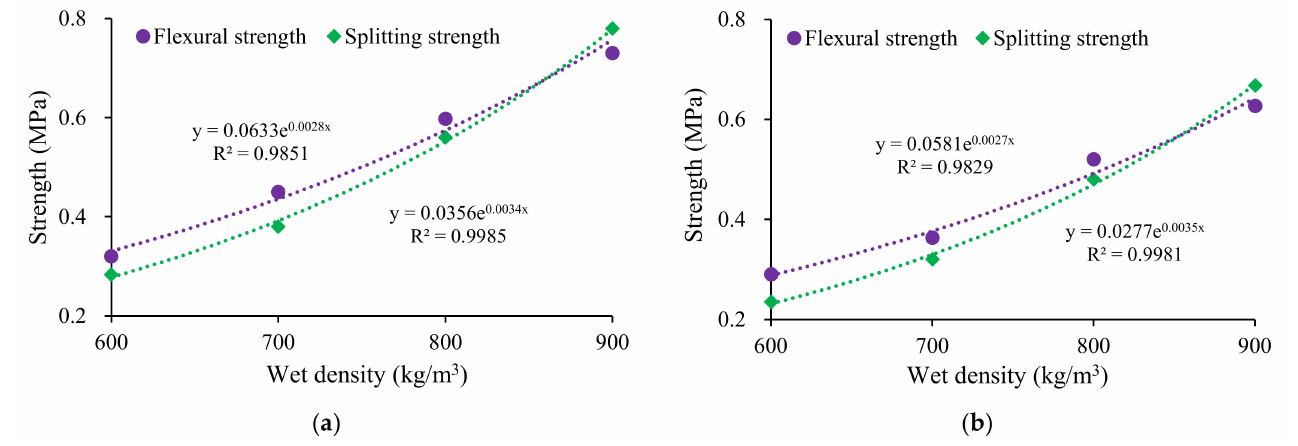
Figure 5. Influence of wet density on tensile properties of mixtures: ( a ) LM–FA dosage of 50%; ( b ) LM–FA dosage 60%.